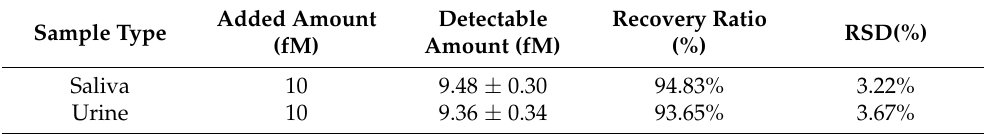
Table 3. Simulated sample determination results.